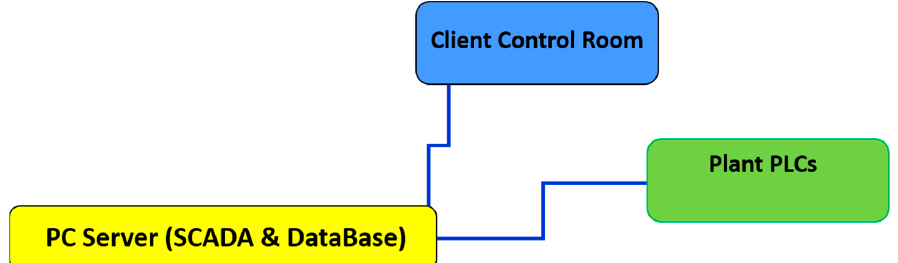
Figure 5. Designed configuration for data acquisition and